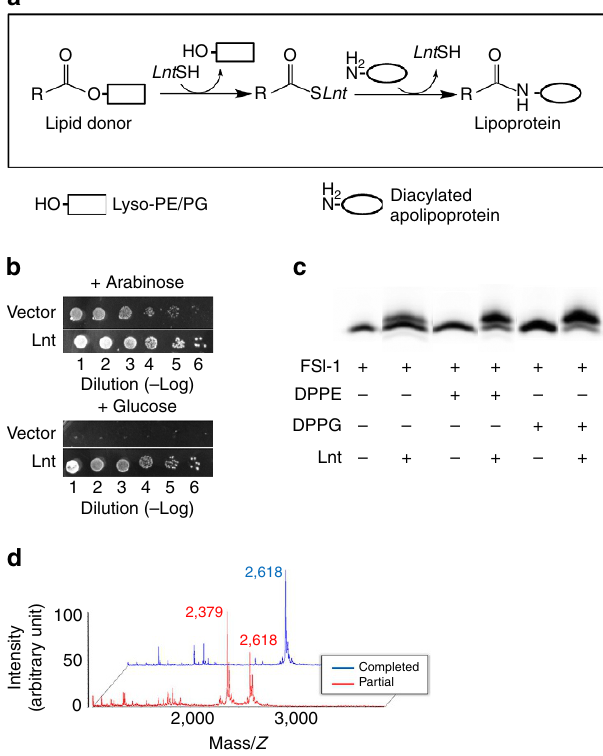
Figure 1 | Functional assays to assess recombinant Ec-Lnt functions. ( a ) Schematic diagram of the two-step reaction catalysed by Lnt (ref. 10). ( b ) Complementation assay of Lnt with the D lnt cell strain. The cell strain contains two plasmids. One serves as a conditional rescuing plasmid and carries the WT Lnt gene which is induced by arabinose but inhibited by glucose. The other plasmid contains constitutively expressed Lnt gene to be tested. A serial dilution of cell culture was spotted onto solid medium containing either 11mM glucose or 1mM arabinose. Images were taken 16h after incubation at 37 (cid:2) C. ‘Vector’ stands for a plasmid without the Lnt gene. ( c ) In vitro transacylation assay. Lnt (3.5nM) was added to a reaction mixture composed of lipids (2.5 m M) and FSL-1 (40 m M). Samples were incubated for 40min at 37 (cid:2) C and analysed by Tricine-SDS–polyacrylamide gel electrophoresis. The lower and upper bands are unmodified and modified substrates of FSL-1 fluorescein, respectively. ( d ) MALDI-TOF mass spectroscopy analysis of the in vitro reaction product. During the full reaction (that is, with both the lipid donor and acceptor), the peak of substrate FSL-1 fluorescein moved from 2,379Da (red peak) to 2,618Da (blue peak), with their mass-difference matching well with the calculated value of 239Da for the acyl chain of palmitic